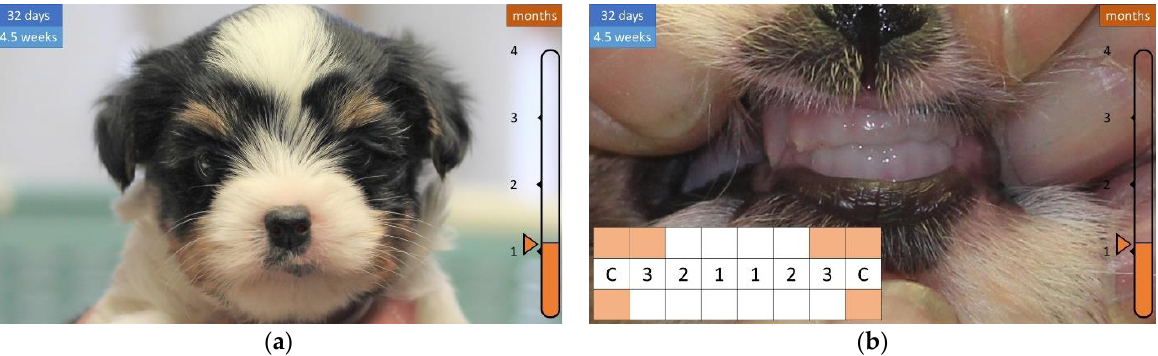
Figure 4. Development of the coat and teeth in the first 32 days of life. ( a ) Longer coat. ( b ) Appearance of the first teeth.